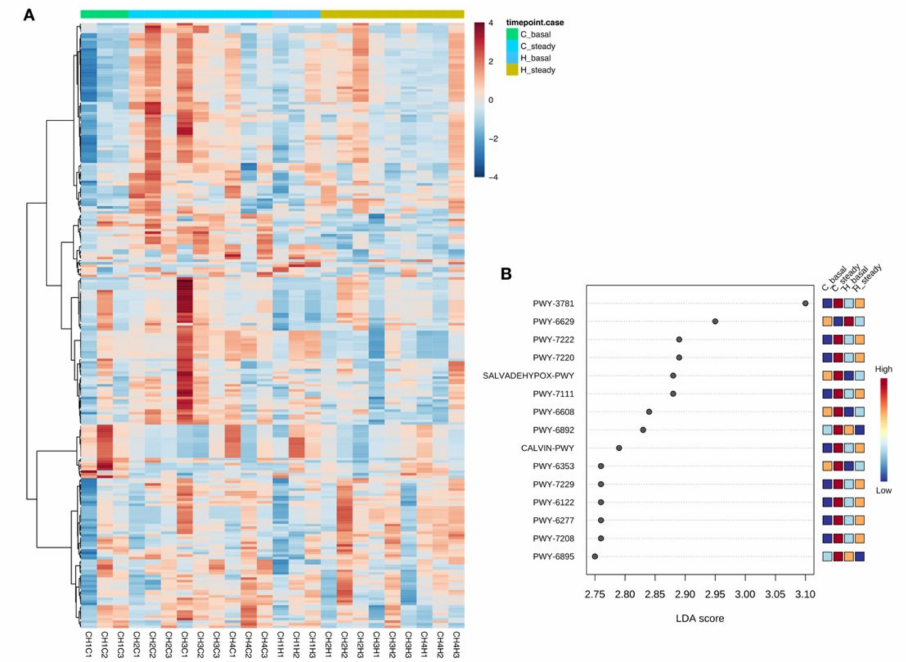
Figure 3. Functional differences in the faecal-derived microbial communities between Coeliac ( n = 1) and healthy donor ( n = 1) samples at baseline and following fermentation with C. pyrenoidosa extract (Sun Chlorella ‘A’ Powder).( A ) Hierarchical clustering of the inferred metagenomes of the study groups (Coeliac (C) vs. healthy (H) donor, at baseline (basal) and steady state (steady) after addition of C. pyrenoidosa extract (Sun Chlorella ‘A’ Powder).The heatmap shows Ward-linkage clustering based on the Kendall’s correlation coefficients of the abundance profile of the 238 most abundant pathways identified. ( B ) Linear discriminant analysis effect size (LEfSe) analysis showing the differentially represented pathways upon addition of C. pyrenoidosa extract (Sun Chlorella ‘A’ Powder) for both C and H samples. The pathways are indicated with the MetaCyc